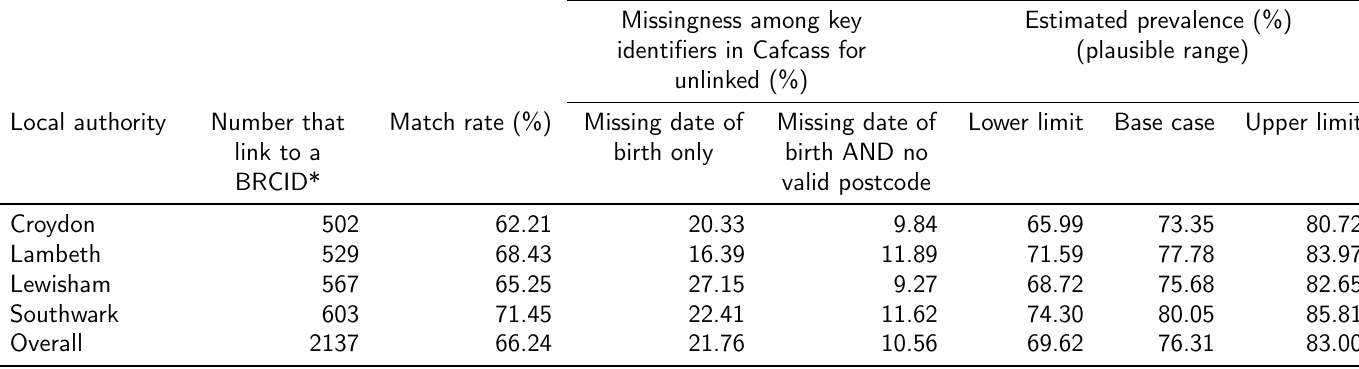
Table 1: Match rate and estimated prevalence of SLaM mental health or substance misuse service user among women involved in care proceedings in Croydon, Lambeth, Lewisham and Southwark between April 2007 and March 2019 (n = 3226)